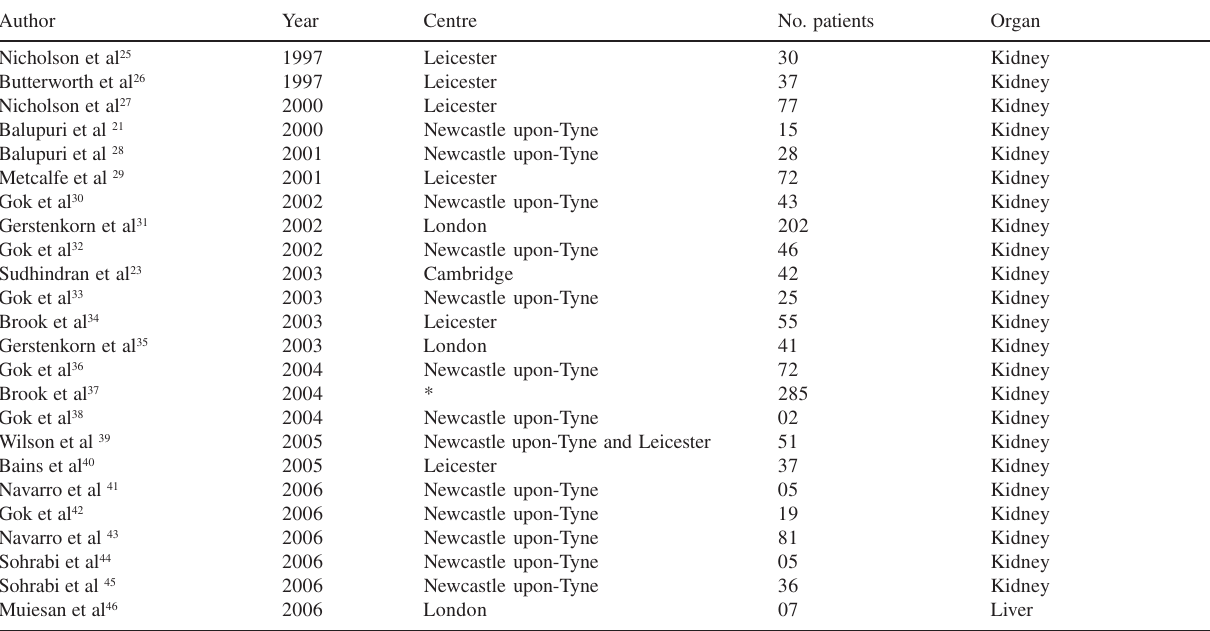
Table 5 - England non-heart-beating donors transplant details